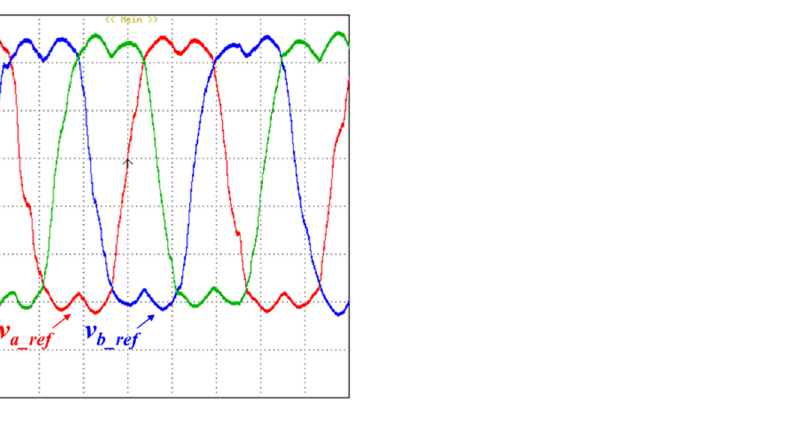
Figure 30. Reference signals for each leg of the power converter when the electric machine operates with a 45 Nm mechanical load (voltage: 2 V/div; time: 10 ms/div).